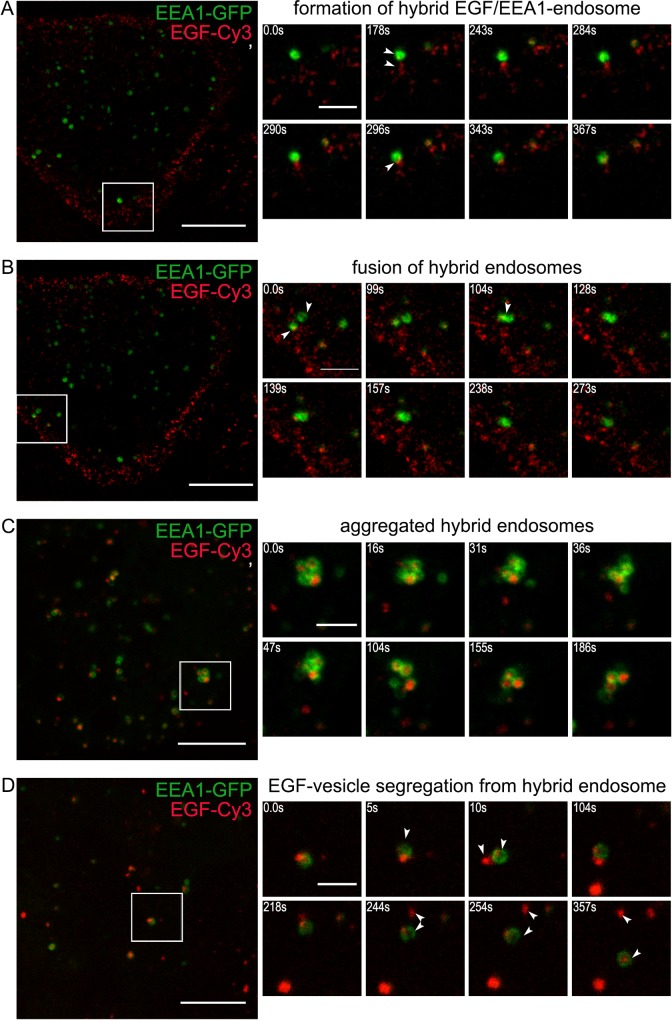
The EEA1-cycle in living HeLa cells expressing EEA1-GFP.EGFR endocytosis was stimulated by EGF-Cy3 (red channel) in HeLa cells transiently expressing EEA1-GFP (green channel) according to the pre-binding protocol (described in the Material and methods section) to synchronize endocytic events. Time-lapse imaging at +37°C was performed. The following stages of the cycle are presented: (A) formation of hybrid EGF/EEA1-endosome (5–10 min), (B) fusion of hybrid endosomes (5–15 min), (C) aggregated hybrid endosomes (15–40 min), (D) EGF-vesicle segregation from hybrid endosome (25–60 min). Scale bars– 10 μm (whole cell) or 3 μm (ROI time-lapse). Arrowheads indicate vesicles of interest. Full movies are presented as S3, S4, S6 and S8 Movies, respectively.